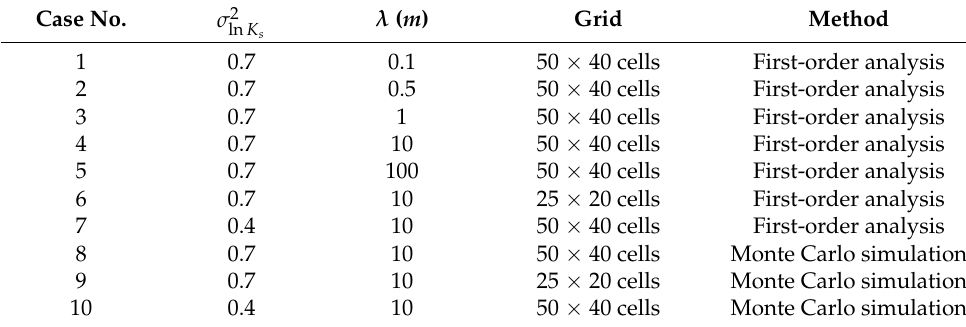
Table 2. Statistics of K s in each study